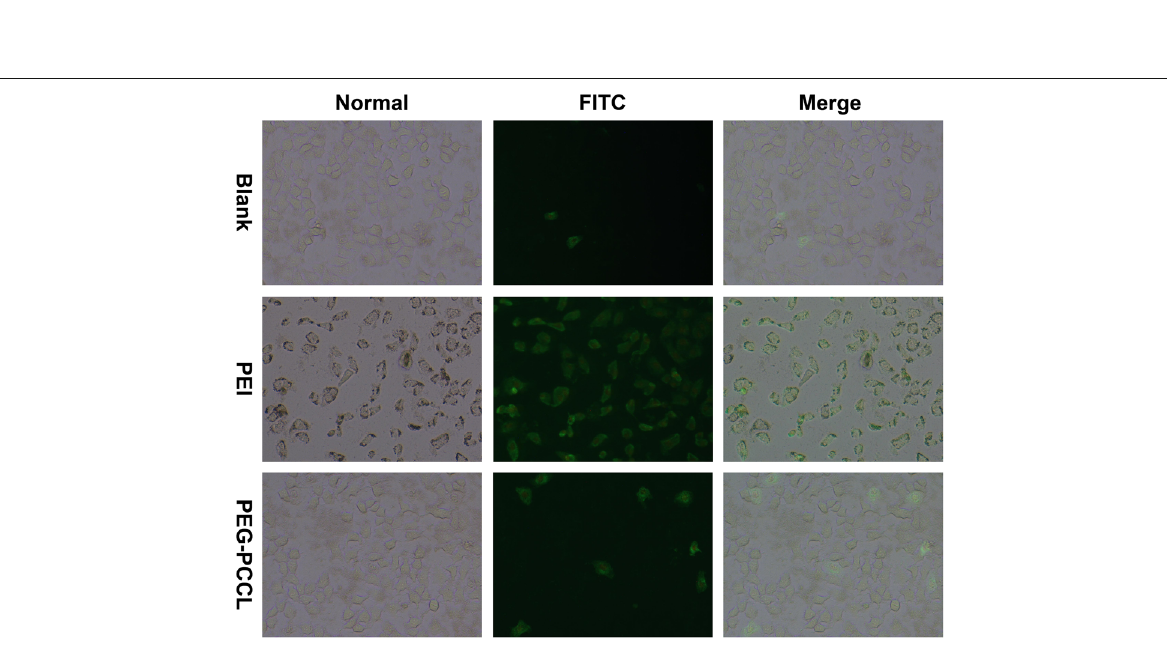
Fig. 5 FITC-Annexin V stain represented cell apoptosis. HepG2 cells incubated with nanoparticles at a concentration of 0.5 mg/mL for 48 h and then co-stained with propidium iodide (red) and annexin V (green) were imaged at ×40